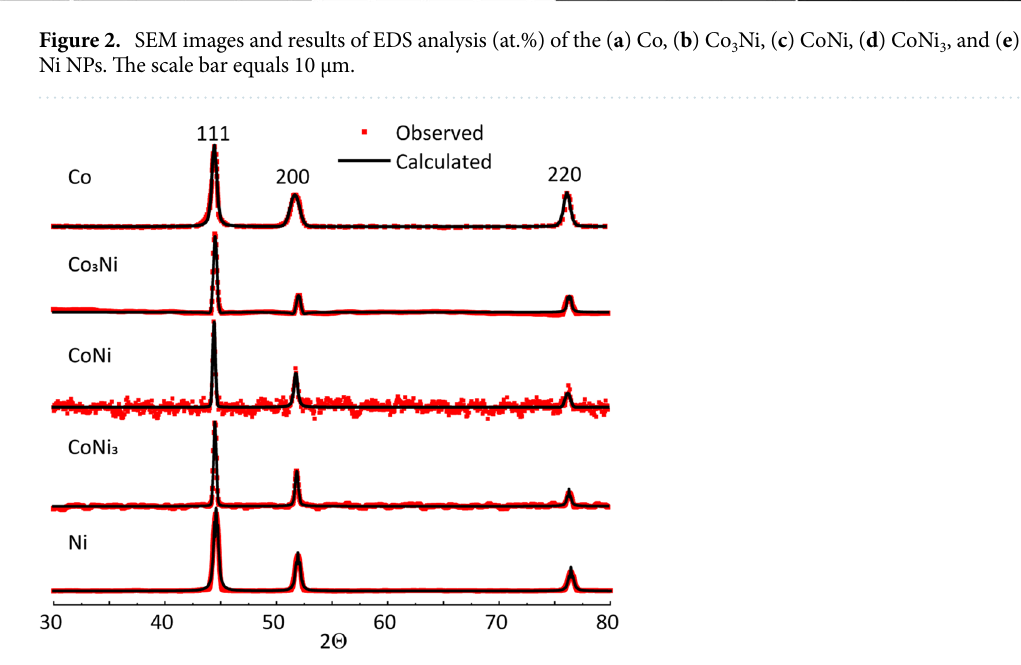
Figure 3. XRD patterns of the Co and Ni-containing